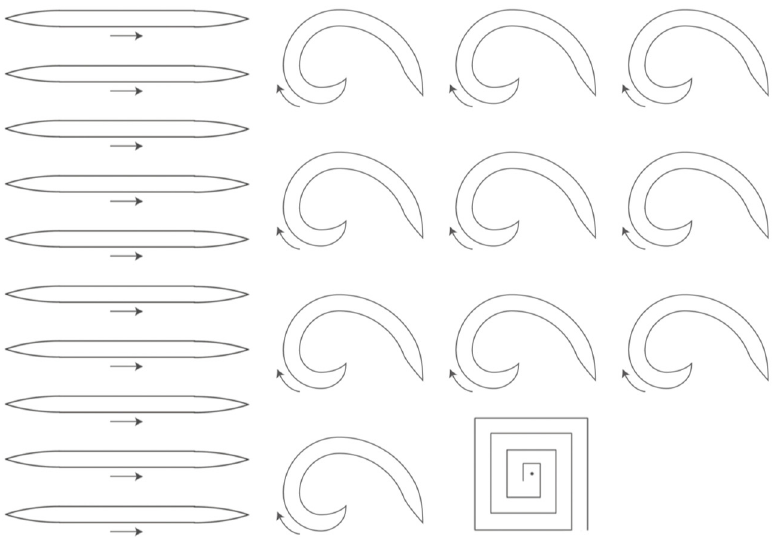
Figure 5. Three writing tasks (straight, curved, and maze tracks) used in this study.